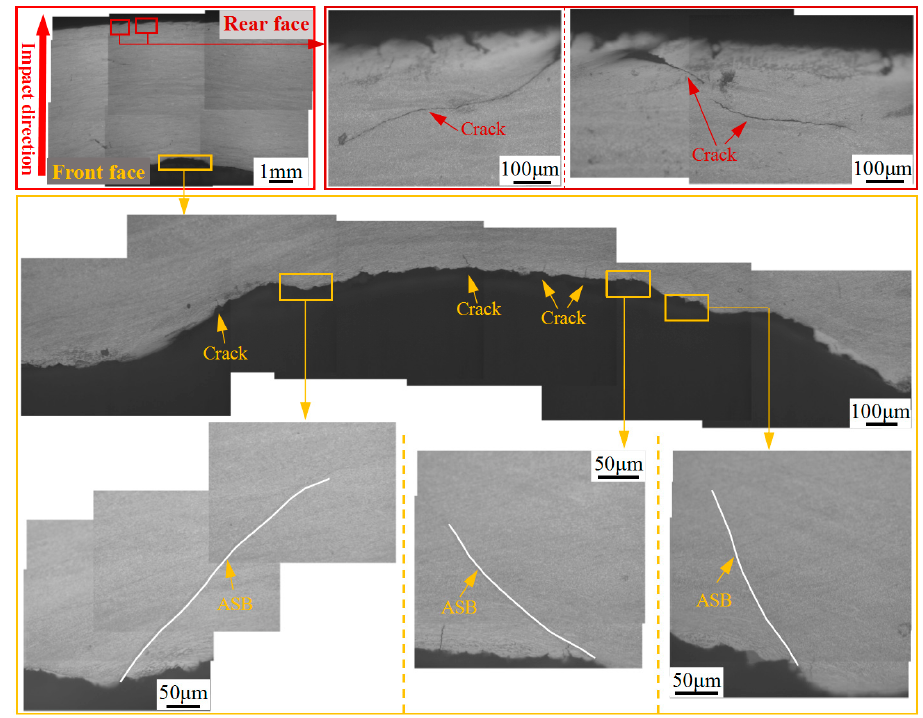
Figure 13. Optical micrographs showing the impact crater half-section of the heat-treated titanium alloy plate.